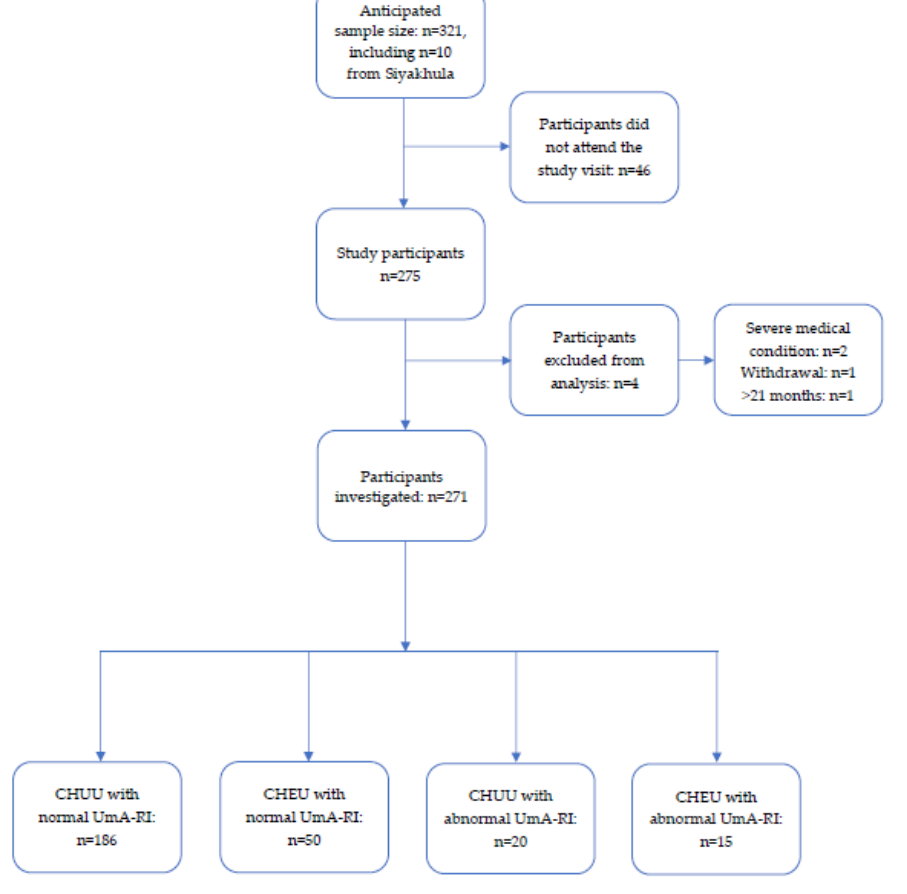
Figure 1. The flow diagram for study participants. Abbreviations: CHEU: children who are HIV- exposed-uninfected; CHUU: children who are HIV-unexposed-uninfected; UmA-RI: umbilical artery resistance index.